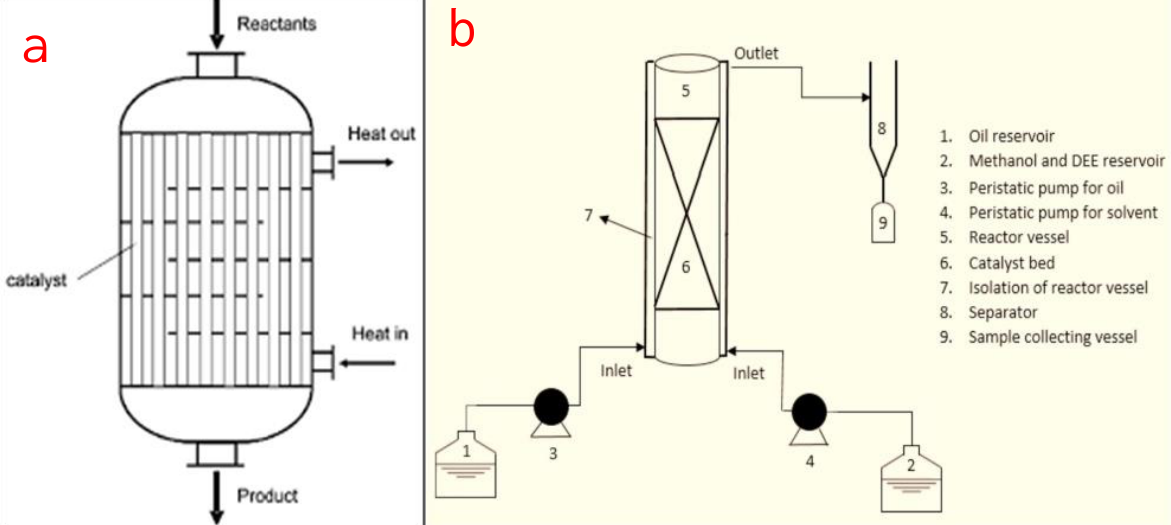
Figure 9. Packed bed reactor. ( a ) schematic representation; ( b ) a packed bed reactor for biodiesel production. Adapted from [72].